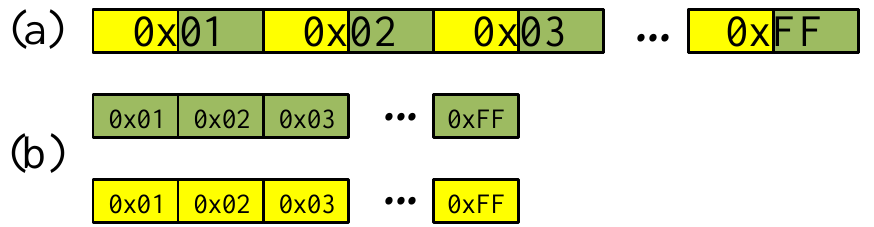
Figure 3. Comparison of LUT construction, ( a ) previous method, ( b ) proposed separated memory access. Yellow and green blocks represent higher and lower parts for LUT,